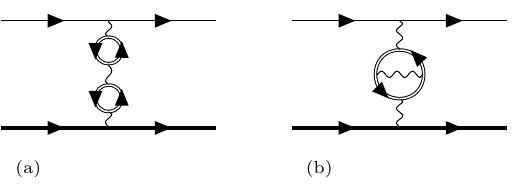
Figure 2. Left: NNLO reducible photon vacuum polarisation contribution. Right: QED NNLO irreducible vacuum polarisation contribution.